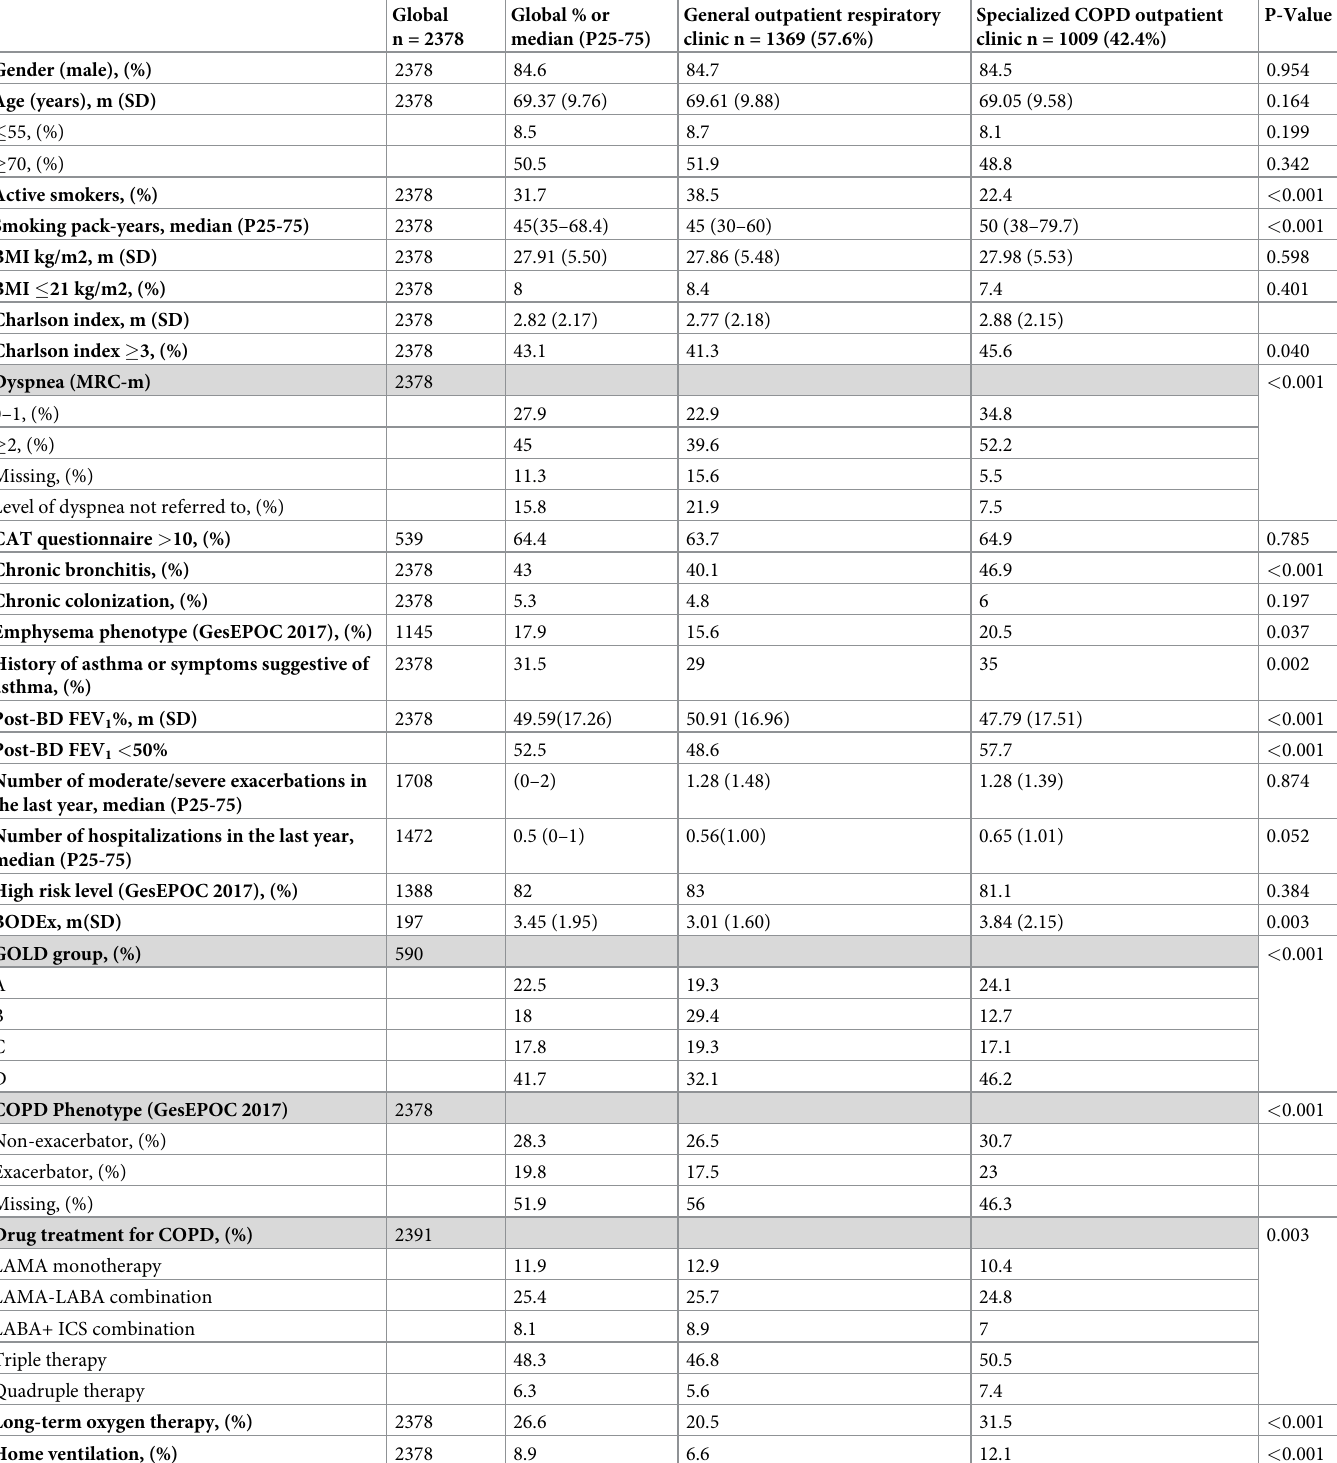
Table 2. Characteristics of the audited cases at both general and specialized outpatient respiratory clinics.